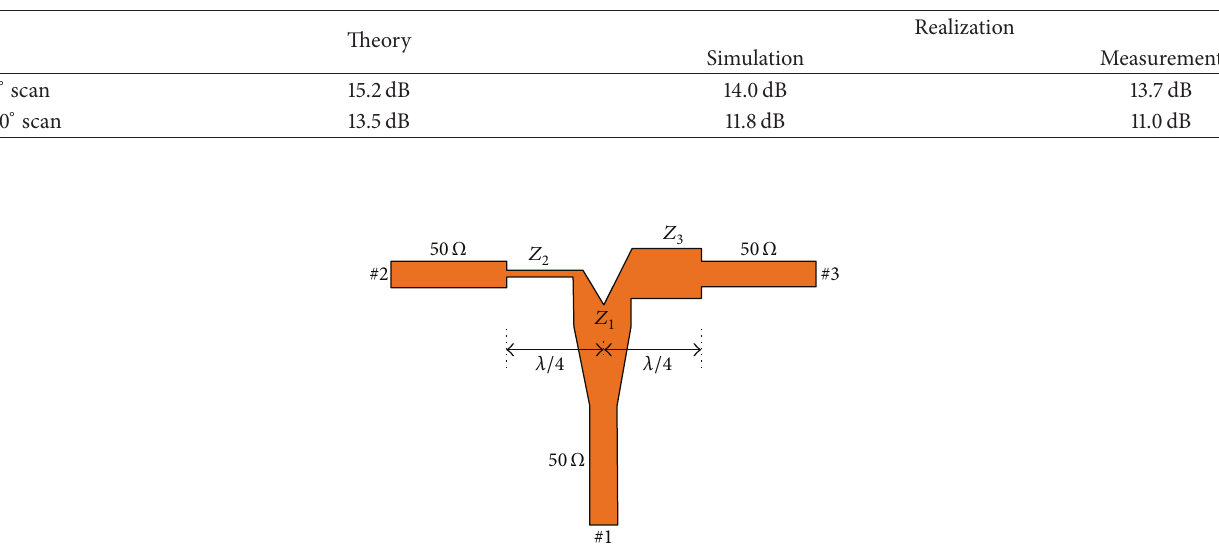
Table 1: Gain of the eight-element linear arrays.